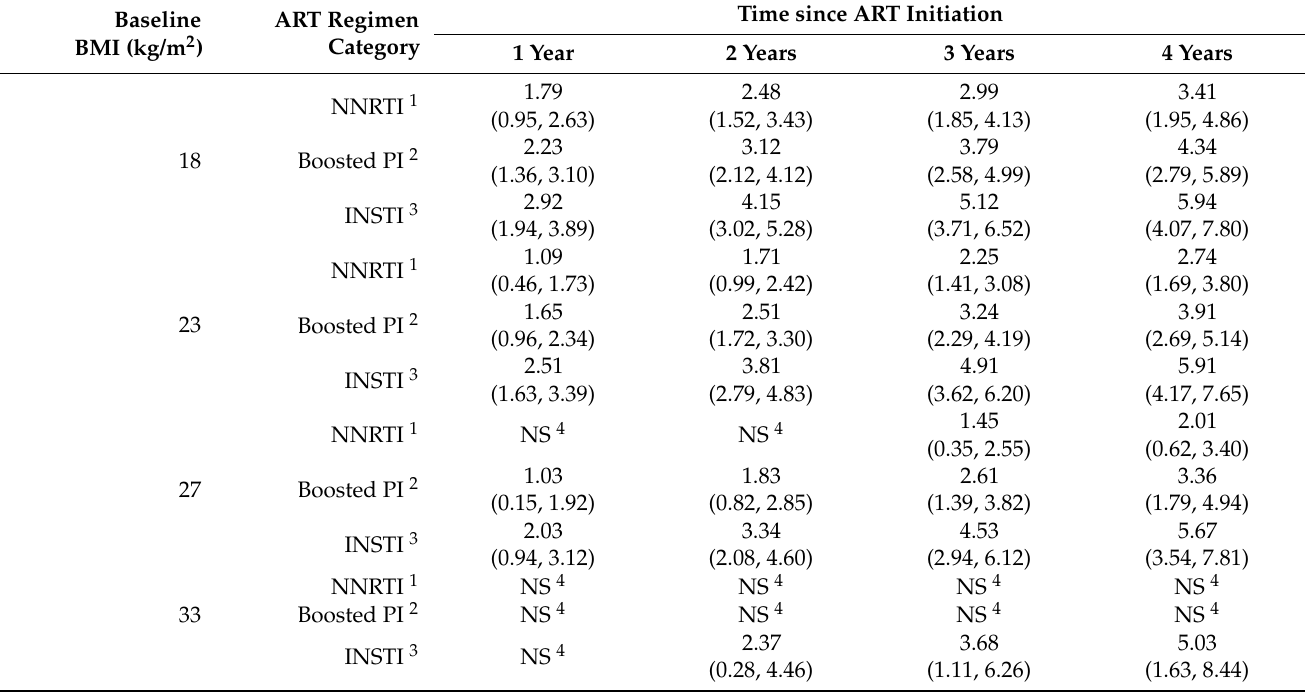
Table 4. Estimated (95% CI) weight gains (kg) by time since ART initiation, baseline Body Mass Index (BMI) and ART regimen category. Estimates shown for men having sex with men, aged 30–39, with no AIDS and with 10,000–49,999 HIV-RNA copies/mL at baseline and assuming height equals 177